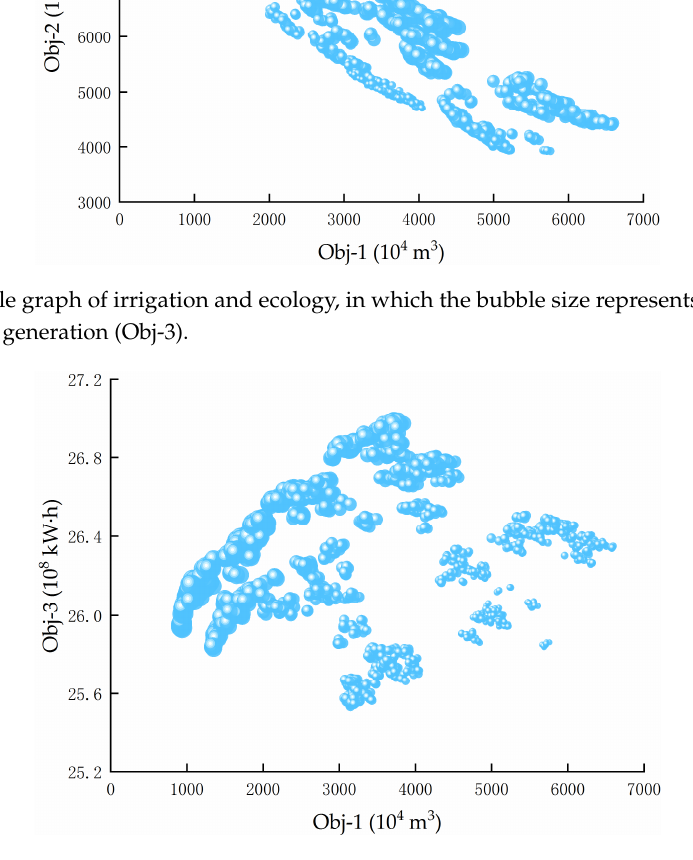
Figure 5. Bubble graph of irrigation and power generation, in which the bubble size represents the multi-year average ecological water shortage (Obj-2).